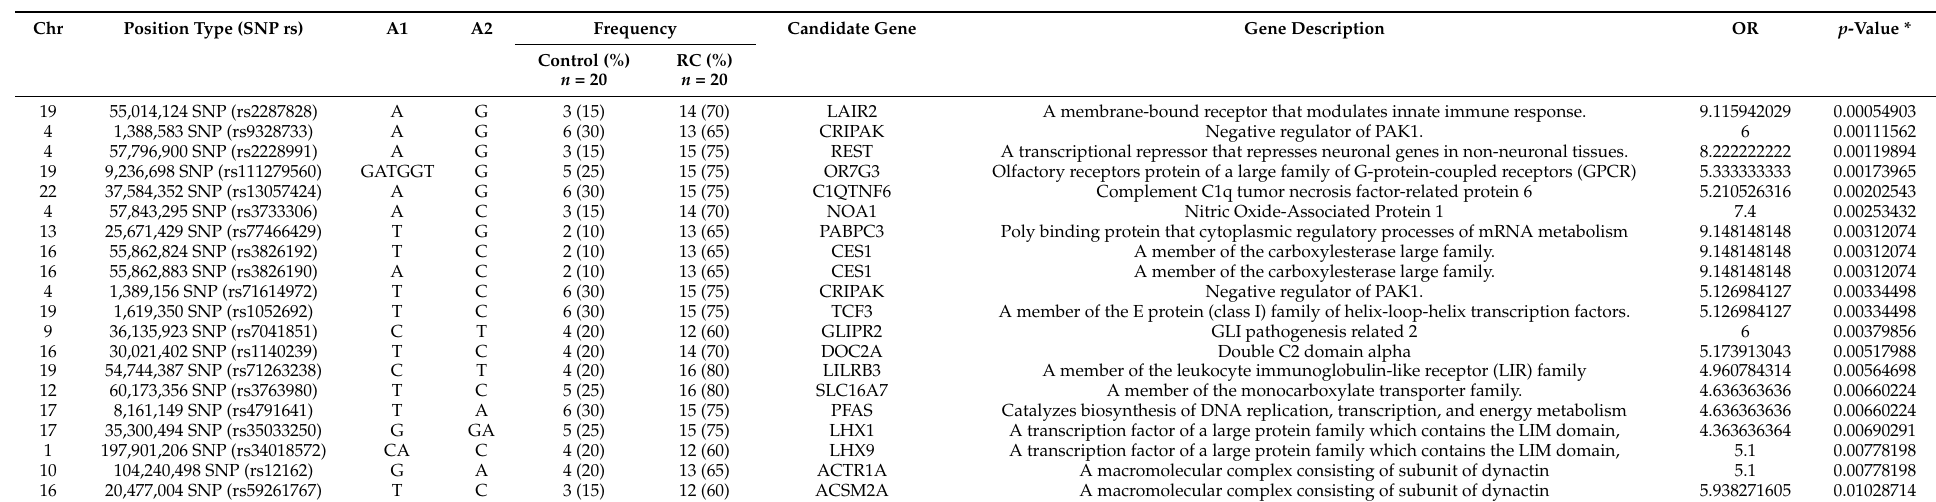
Table 2. Identified candidates of genetic variants associated with RC